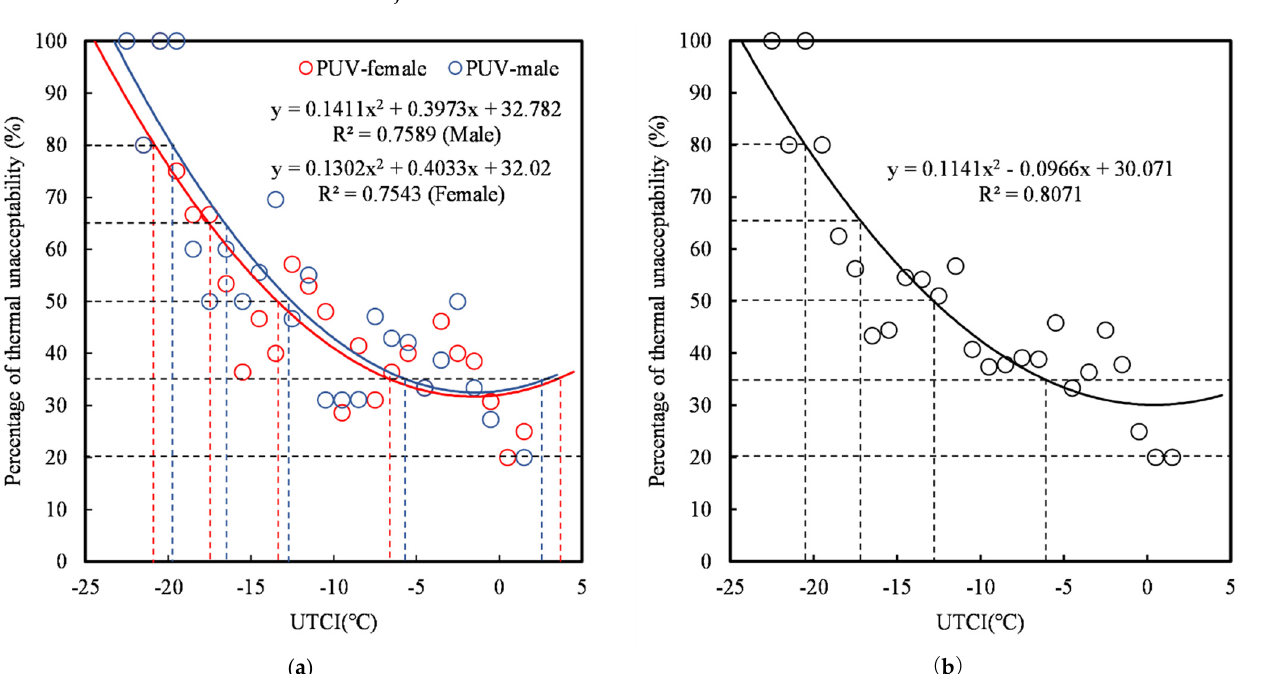
Table 6. UTCI calibrations for different stress categories.